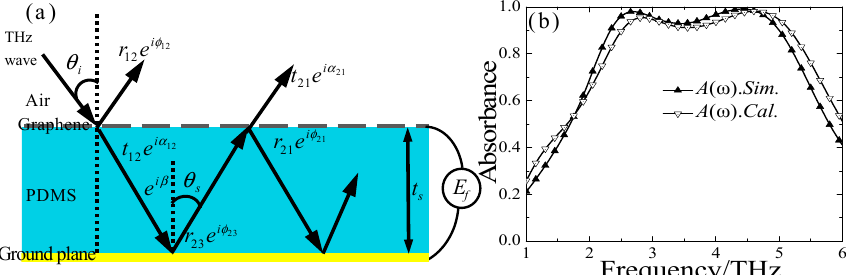
Figure 4. ( a ) Illustration of the interference model of the proposed MMA, and ( b ) the simulated and calculated absorbance of the designed MMA when E f = 0.8 eV.